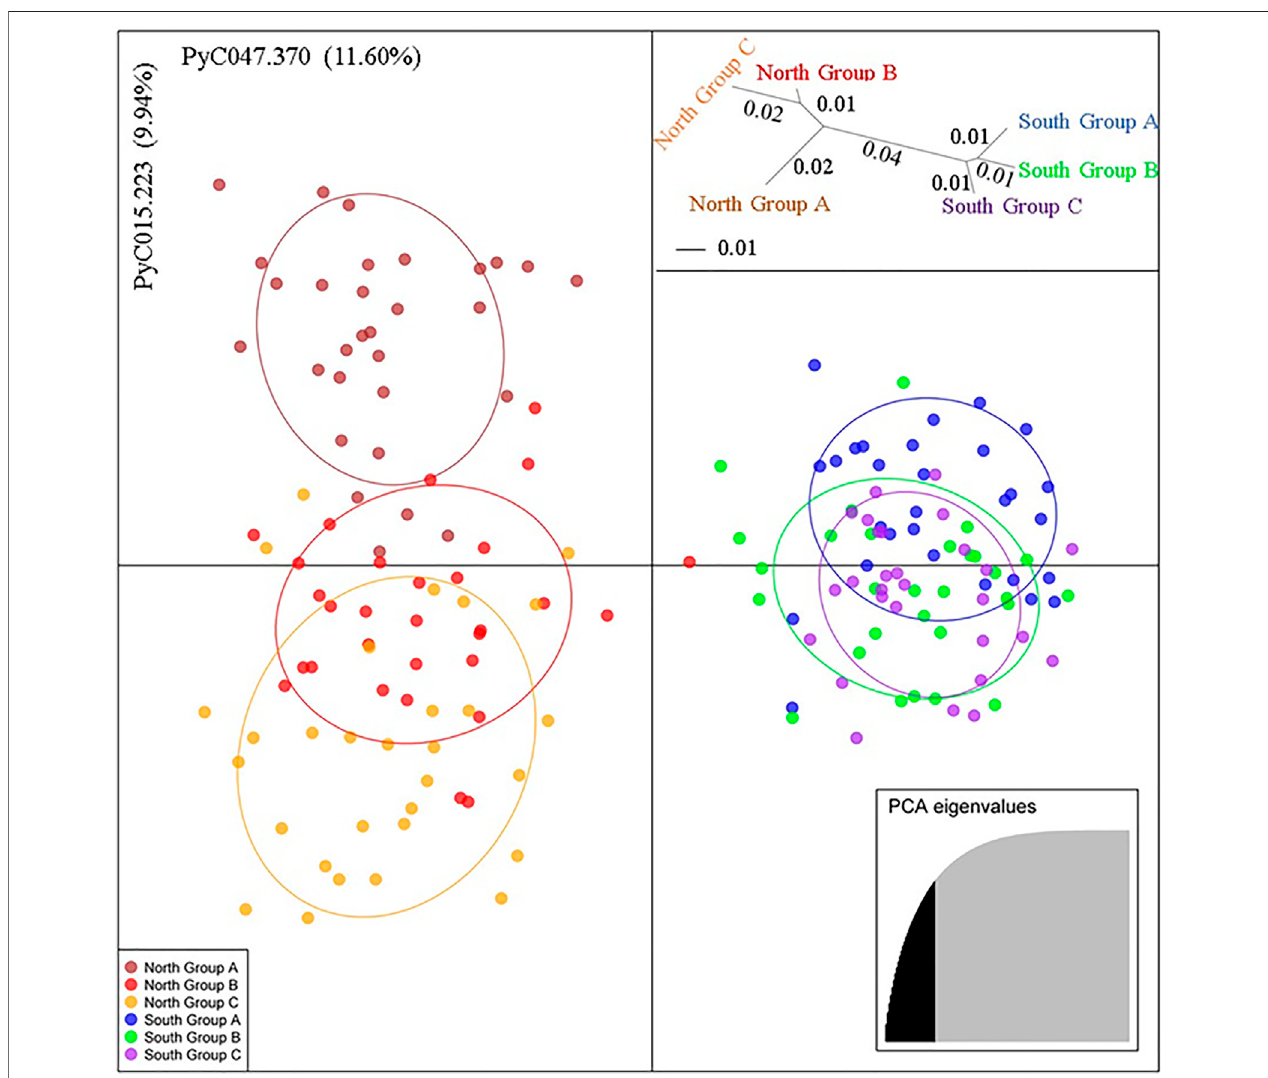
FIGURE 4 | Discriminant Analysis of Principal Components (DAPC) of the Pyrus calleryana dataset. The alleles that explained the most of variance within the sampled populations (and their contributions) are indicated along X and Y axes. Each of the six colors represent six subpopulations (Brown: North Group A, Red: North Group B, Orange: North Group C, Blue: South Group A, Light Green: South Group B, and Purple: South group C), indicated in the legend (bottom-left). The genetic distance tree (insert top right) represents the unrooted neighbor-joining tree of pairwise genetic distances (Nei, 1978) among the sampled 176 P . calleryana individuals. This genetic distance for each split is followed by 70% or higher bootstrap, based on 1000 permutations of the distance matrix (distance/bootstrap). As shown in the bottom-right insert, 33 PCAs that saturated the cumulative variance at about 80% were selected, to visualize the dataset.